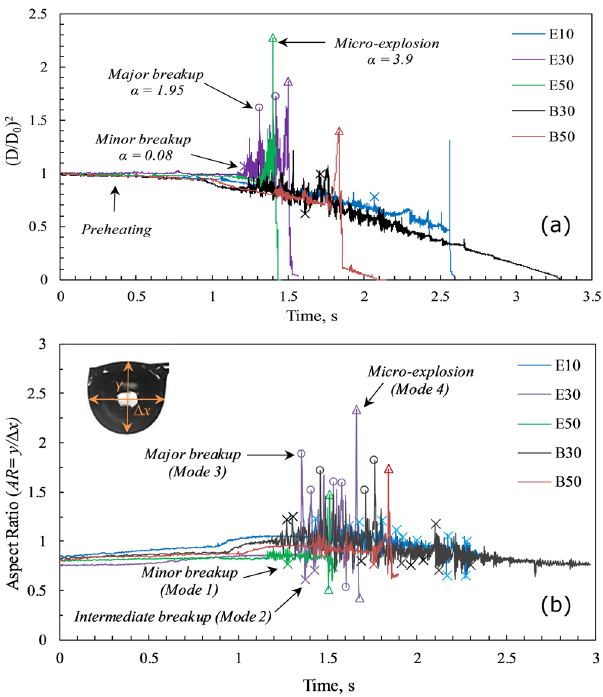
Figure 10. ( a ) Temporal evolution of droplet diameters and ( b ) Temporal evolution of aspect ratio fluctuations of ethanol and butanol blends. Circles indicate high-intensity major bubble breakups. Cross markers indicate minor and intermediate bubble breakups and triangle markers indicate